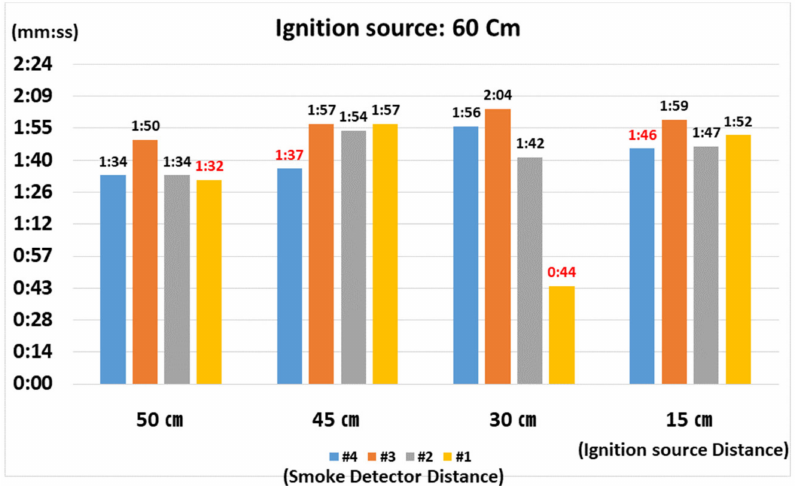
Figure 16. Elapsed time until smoke detection for ignition source height of 60 cm. The fastest detection times for each ignition source distance were 1 min and 46 s at 15 cm, 44 s at 30 cm, 1 min and 37 s at 45 cm, and 1 min and 32 s at 50 cm. Two of these results were obtained for smoke detector #1, whereas the remaining two were obtained for smoke detector #4.